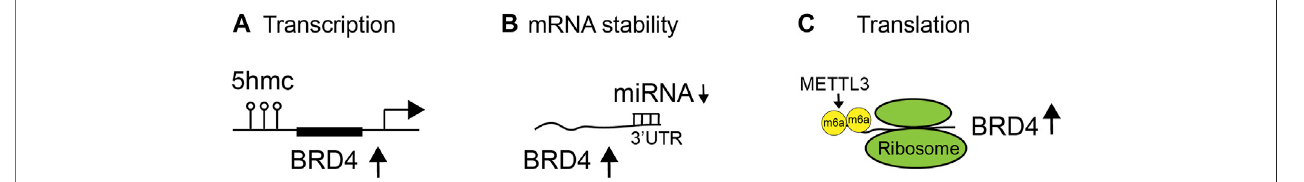
FIGURE 2 | Regulation of BET protein expression and functions in diseases. Expression and activity of BET proteins are regulated at different levels, including (A) transcription by 5-hydroxymethylcytosine (5-hmC) at the BRD4 promoter, (B) messenger RNA (mRNA) stability by binding of microRNA (miRNA) to the 3 ′ untranslated region (UTR) of BRD4 mRNA transcripts, and (C) translation by N 6 -methyladenosine (m 6 A) modi fi cation of mRNA (Rahman et al., 2011).